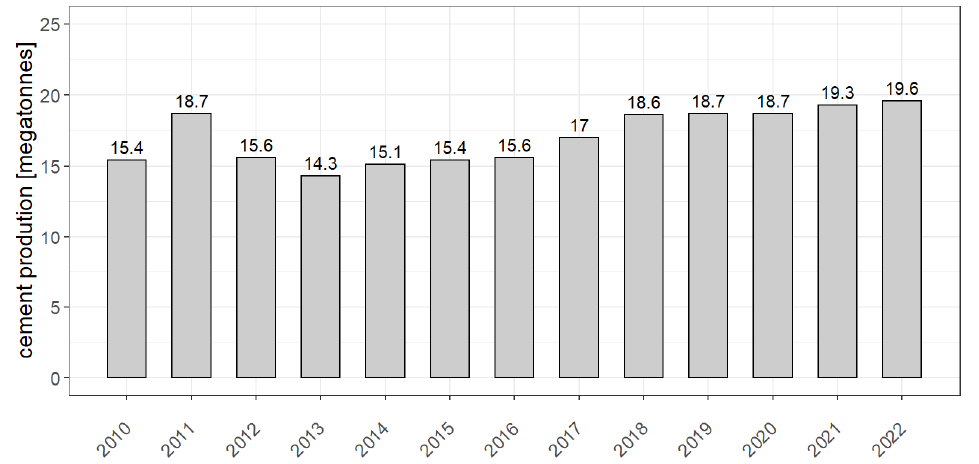
Figure 1. Sales of cement in Poland in the years 2010–2022. Source: https://www.polskicement. Figure 1. pl/aktualnosci/produkcja-cementu-w-polsce-rosnie-niestety-import-z-bialorusi-tez/ (accessed on 24 July